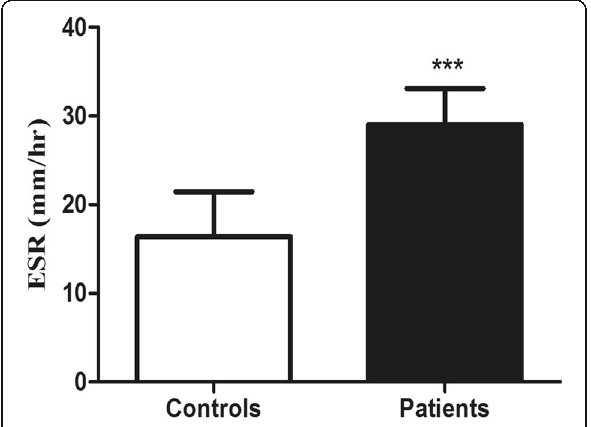
Fig. 1 Erythrocyte sedimentation rate of pregnant healthy controls and pregnant SLE patients. Values are expressed as Mean±SD. *** p